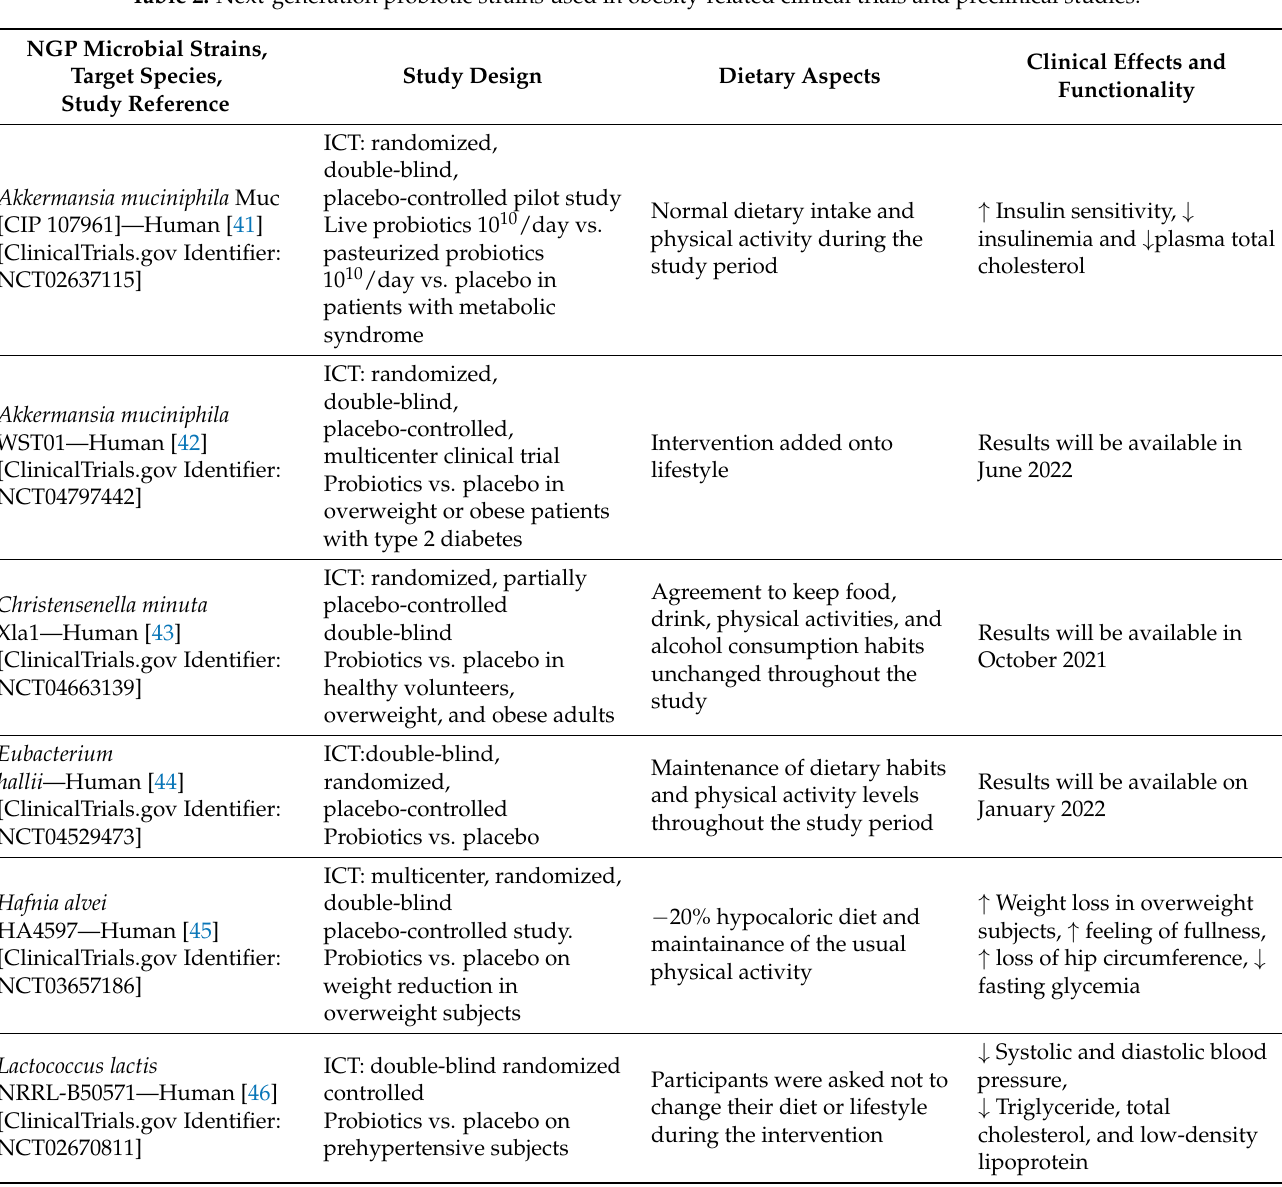
Table 2. Next-generation probiotic strains used in obesity-related clinical trials and preclinical studies. NGP Microbial Strains, Target